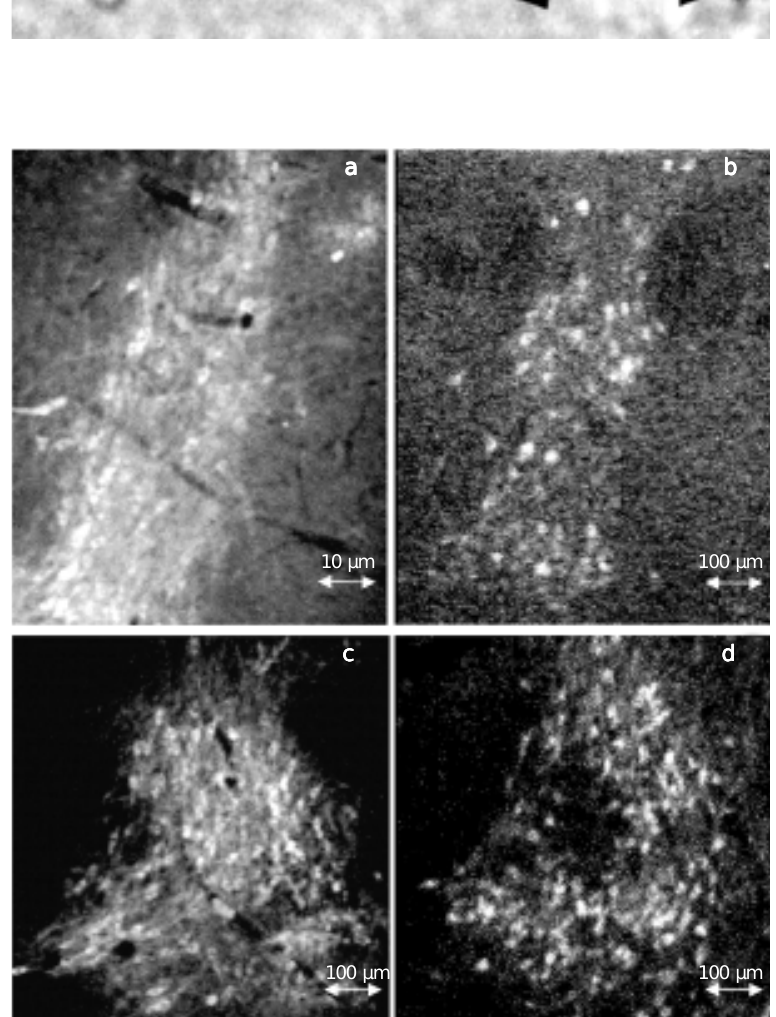
Figure 3. Micrograph of a mouse substantia nigra pars compacta stained with hematoxylin-eosin 1 month post-inoculation of 5 x 10 6 colony forming units of Nocardia otitidiscaviarum (GAM-5). A hyaline intracyto- plasmatic inclusion (arrow) similar to the Lewy bodies can be seen. Note the presence of Nocardia in the neuron cytoplasm (arrowhead).